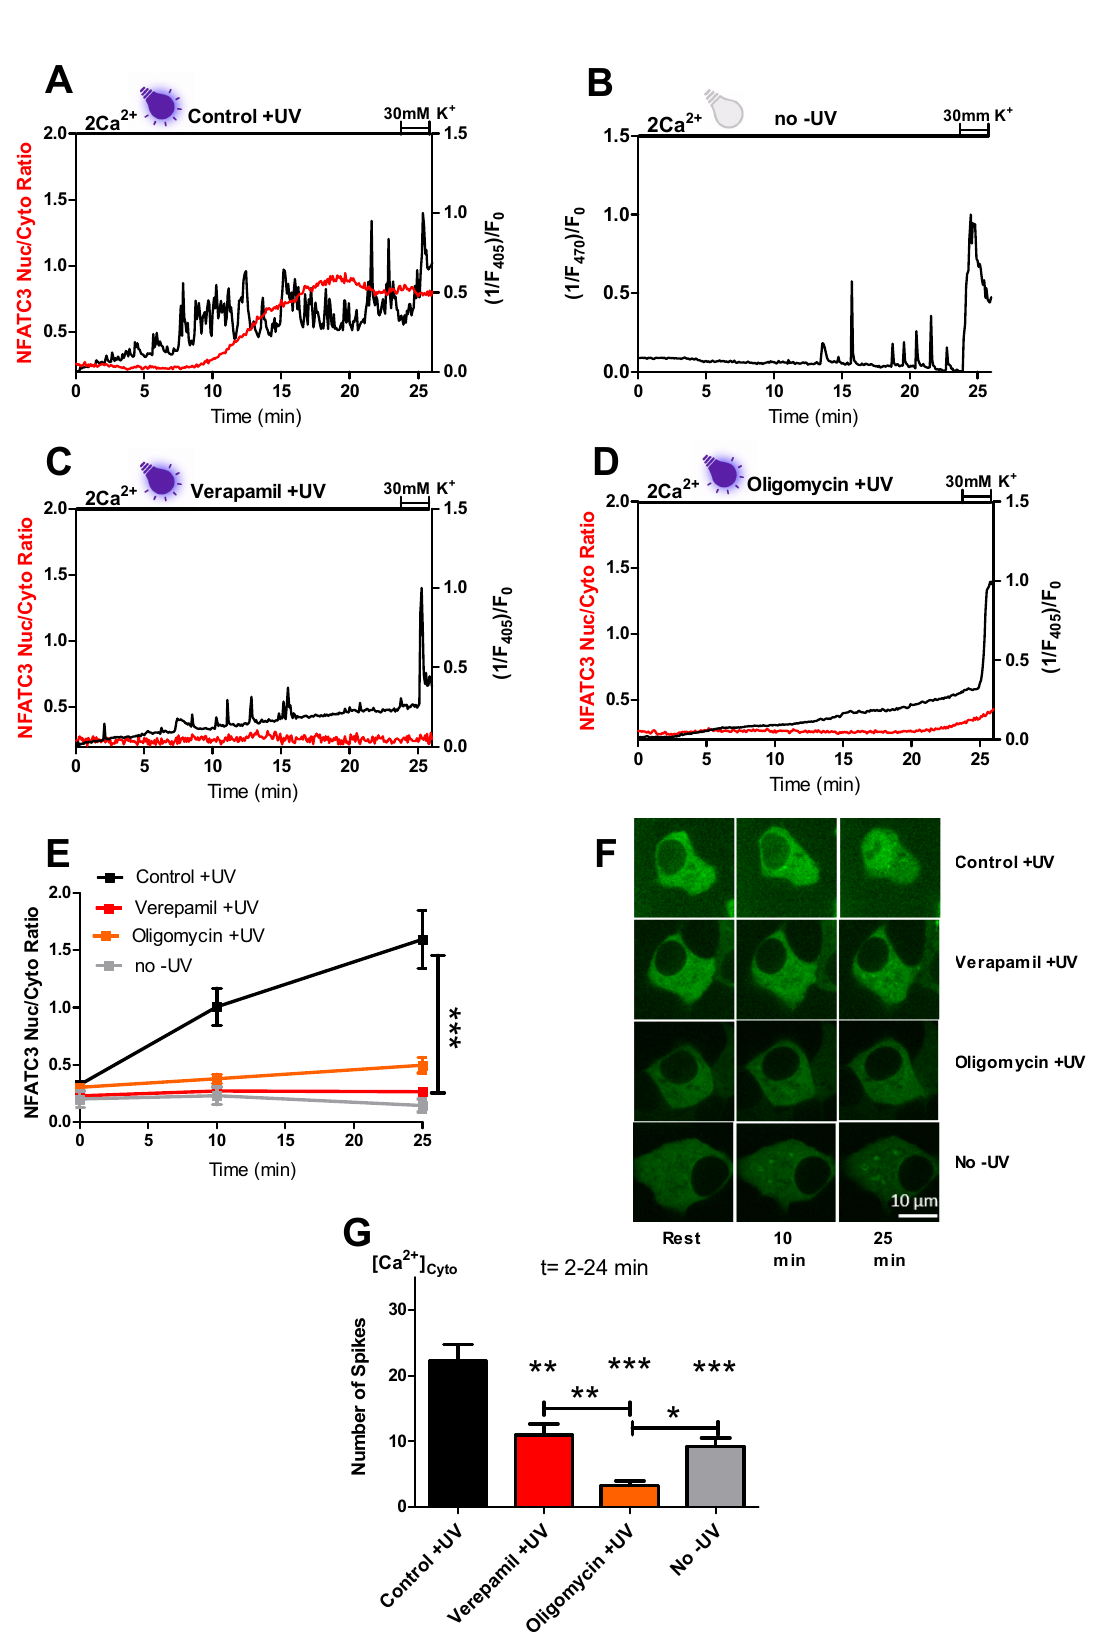
Figure 2. Near-UV light induces repetitive cytosolic Ca 2+ spiking and GFP-NFATc3 translation to the nucleus via activation of L-type Ca 2+ channels. Representative trace of repetitive cytosolic Ca 2+ spikes (black trace) measured with Fura-2 by